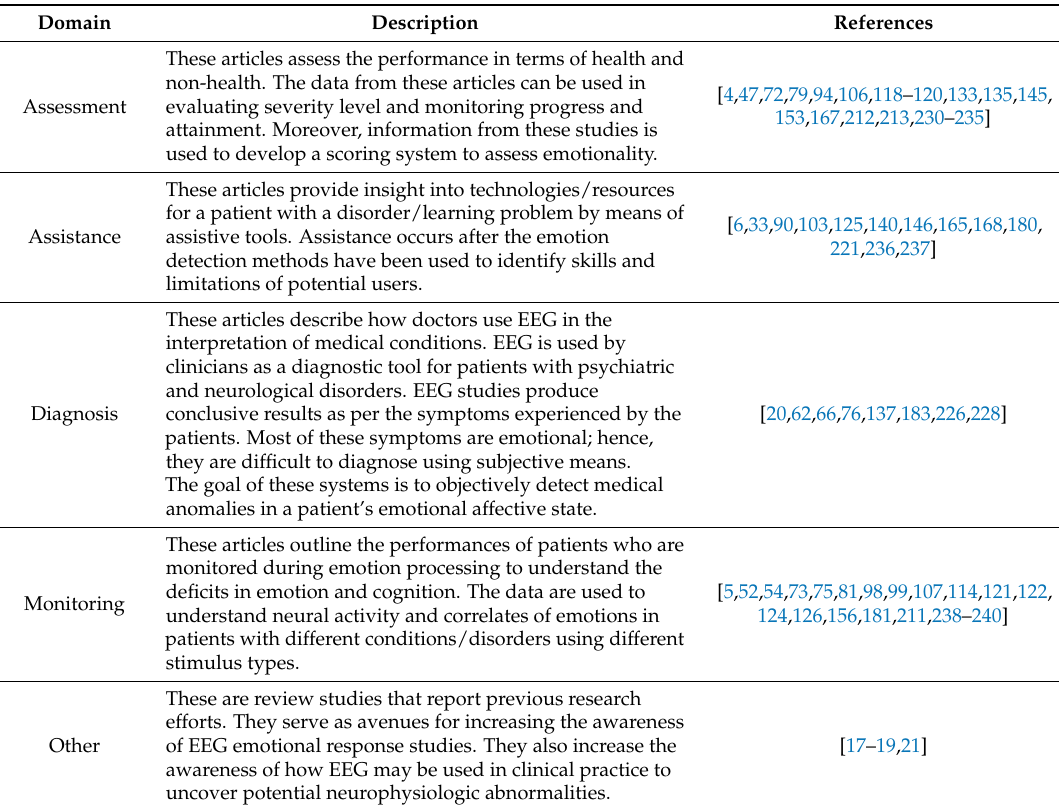
Table 6. Medical application